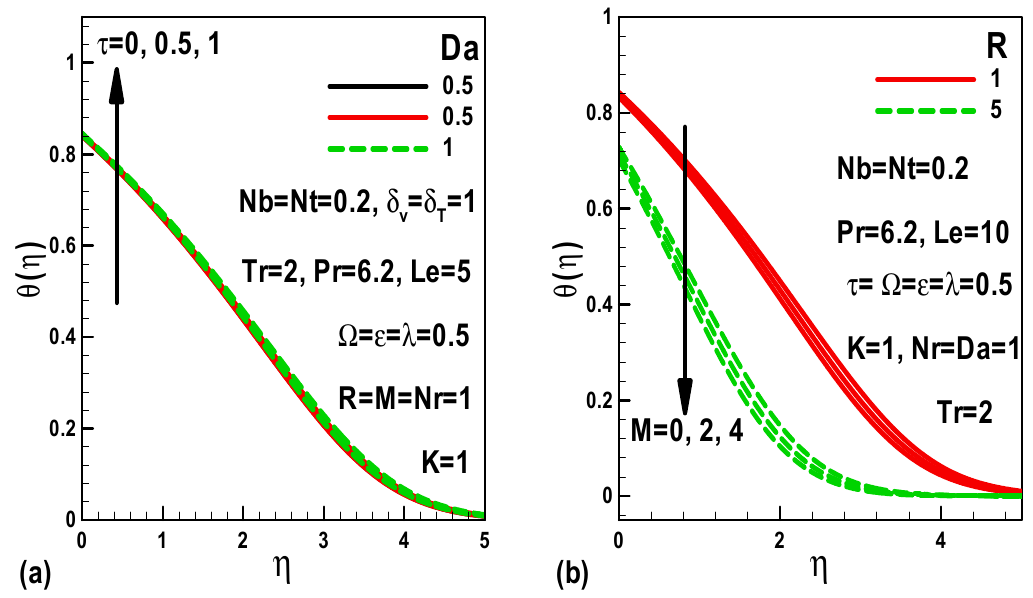
Figure 7. Effects of several parameters on dimensionless temperature with pressure gradient.